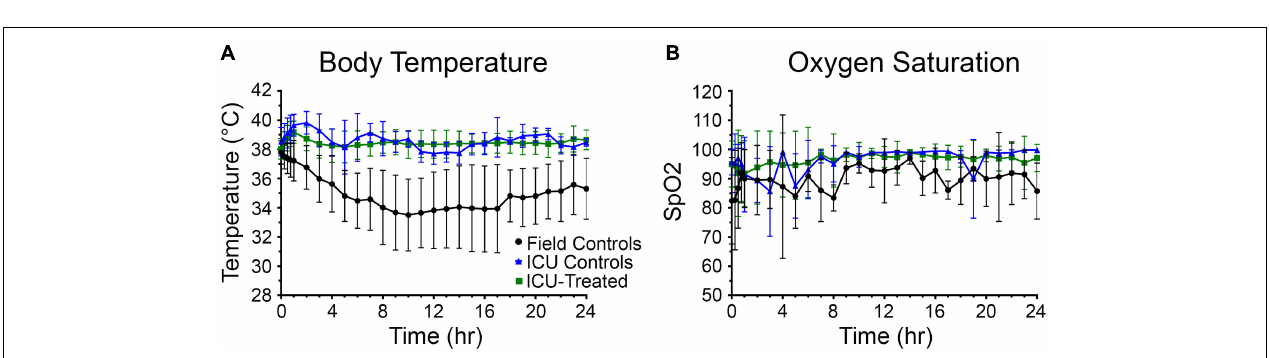
FIGURE 2 | Representative EEG traces from one field control rat and two rats that were treated in the ICU. (A) The field control rat remained in SE for the duration of the 24 h recording session. (B) For one ICU-treated rat, SE terminated when phenobarbital (PHB) was delivered, and the rat remained seizure-free for 24 h. (C) For the other ICU-treated rat, SE initially terminated with ketamine (KET), but seizure activity returned as KET was withdrawn. Black arrows indicate location of insets on the right side of the panels. Red, blue, and purple arrows indicate treatment times for first-, second-, and third-line drugs, respectively. Scale bars for the main panels show 2 h in the x -direction and 0.5 mV in the y -direction. Scale bars for the insets shows 5 s in the x -direction and 0.25 mV in the y -direction.